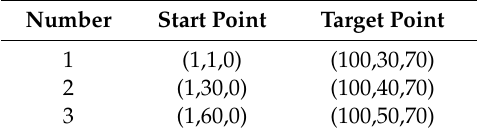
Table 9. Coordinates of the starting and target points of all UAVs (case